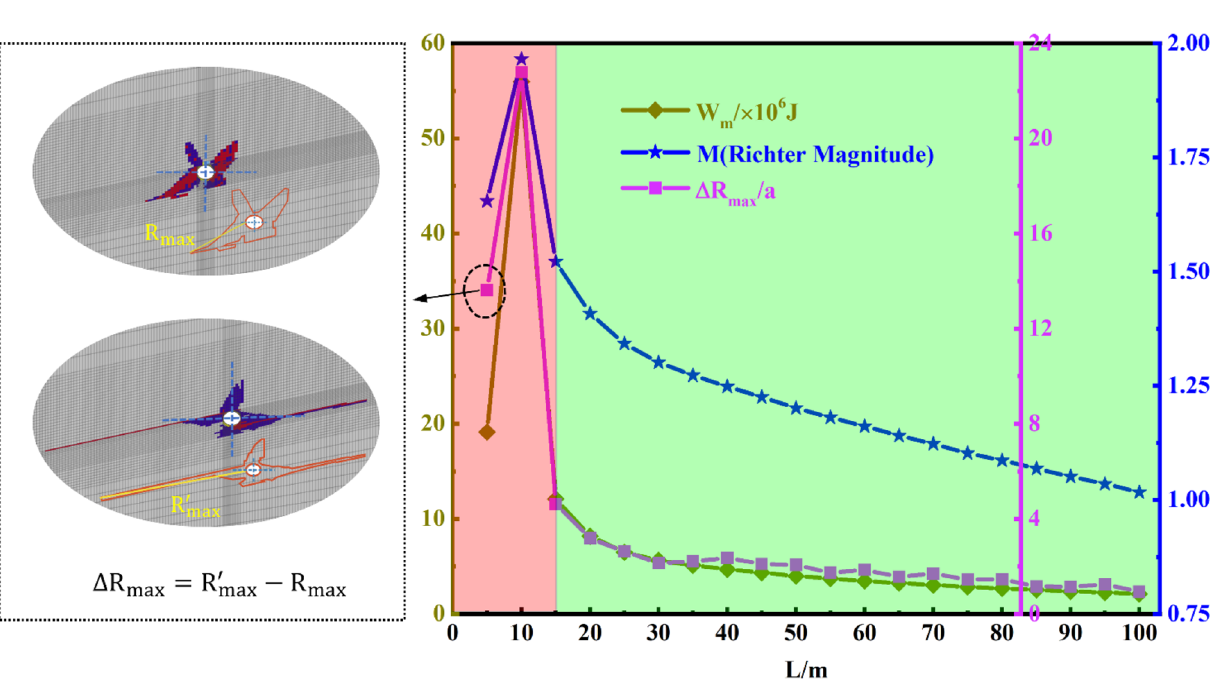
max , Elastic energy released and corresponding Richter